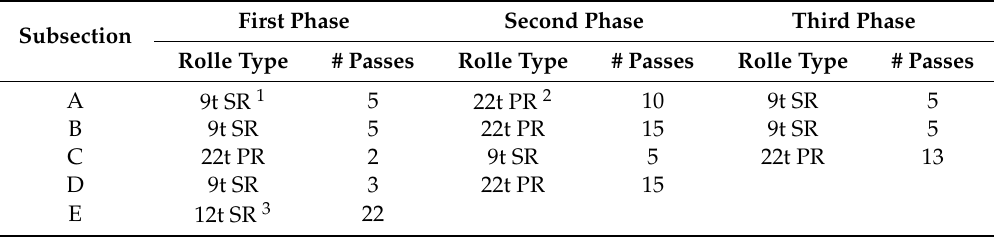
Figure 5. Scheme of the Subsections composition. Table 7. Compaction procedure of the cold recycled asphalt mixture (CRAM) binder